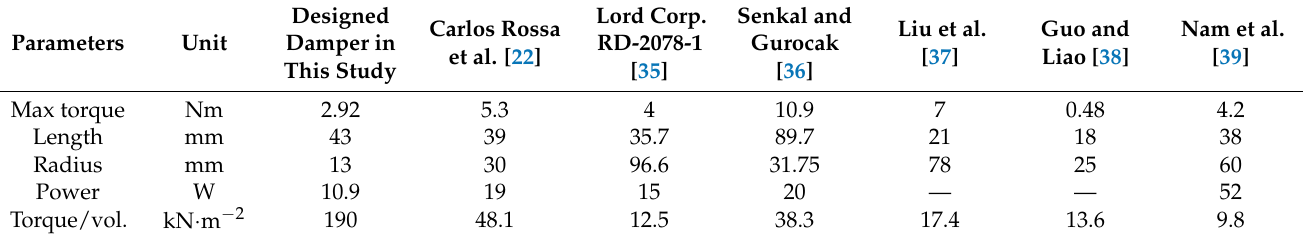
Table 2. Comparison among different rotary dampers.